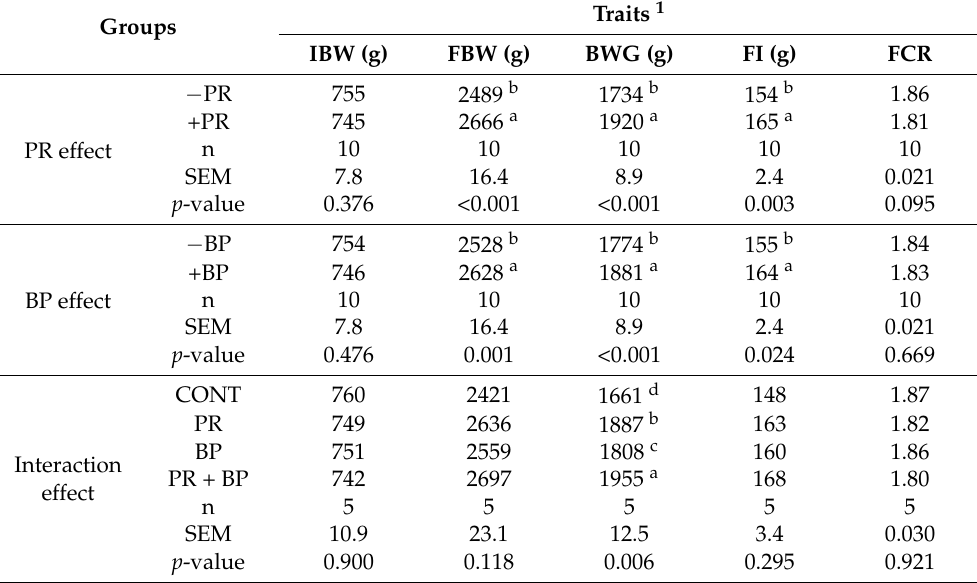
Table 3. Effect of propolis (PR), bee pollen (BP), and their interaction (PR + BP) on the productive performance of broiler chickens.